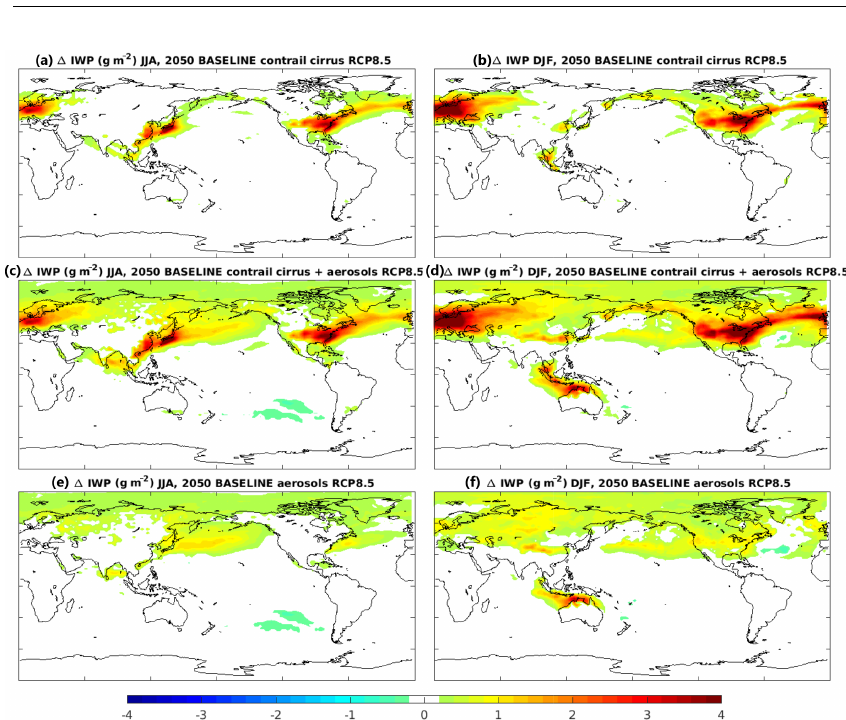
Figure 8. Ensemble mean of seasonally averaged (JJA: a, c, e , DJF: b, d, f ) ice water path difference in gm − 2 due to contrail cirrus (a, b) , contrail cirrus and aviation aerosols (c, d) and aviation aerosols (e, f) based on the 2050 baseline emissions with RCP8.5 2050 meteorology. Only ensemble-mean perturbations above 2 standard deviations of the averaged control simulations are